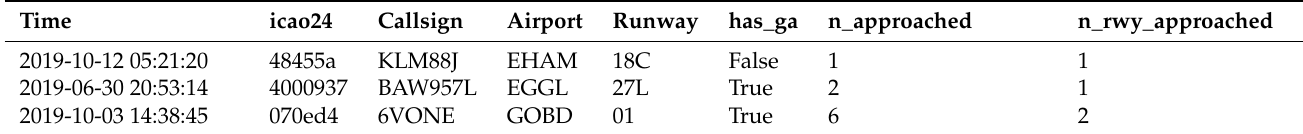
Table 2. Landing dataset content